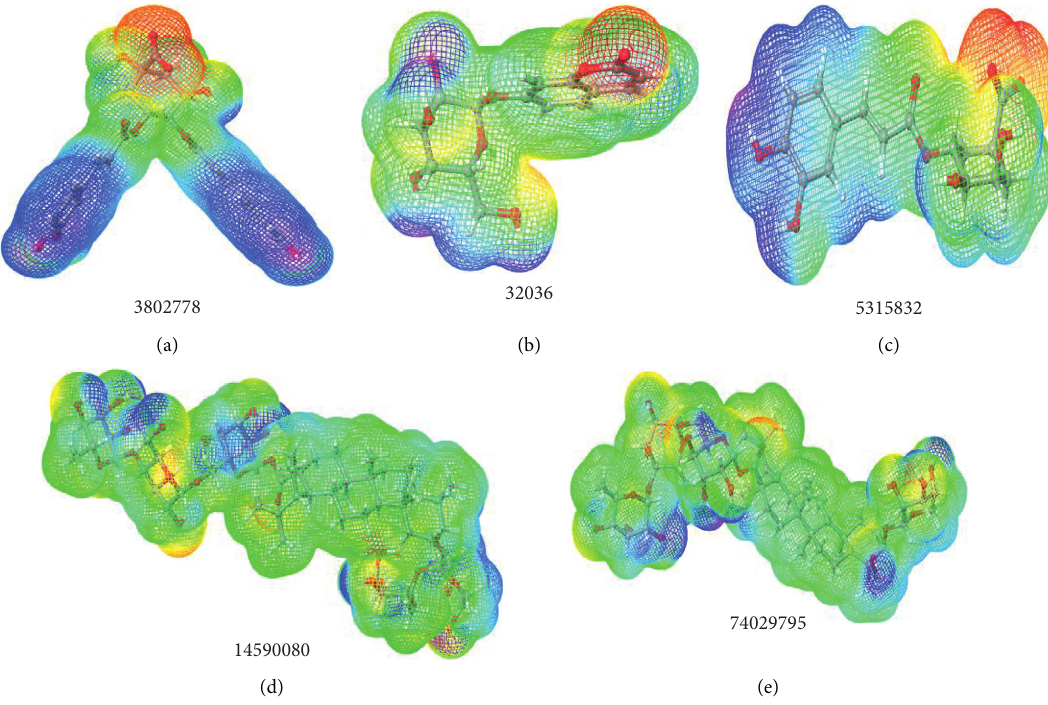
Figure 5: MESP mapping of 3802778 (a), 32036 (b), 5315832 (c), 14590080 (d), and 74029795 (e) homeopathy compounds. The most negative electrostatic potential was colored deepest red, and the most positive electrostatic potential was colored deepest blue. The in- termediate yellow, orange, and green shades indicate the ranges of